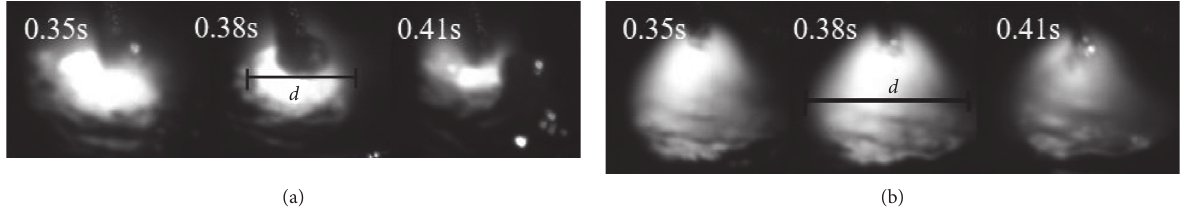
Figure 3: Arc shape with different shielding gases. (a) 98%Ar +2%N